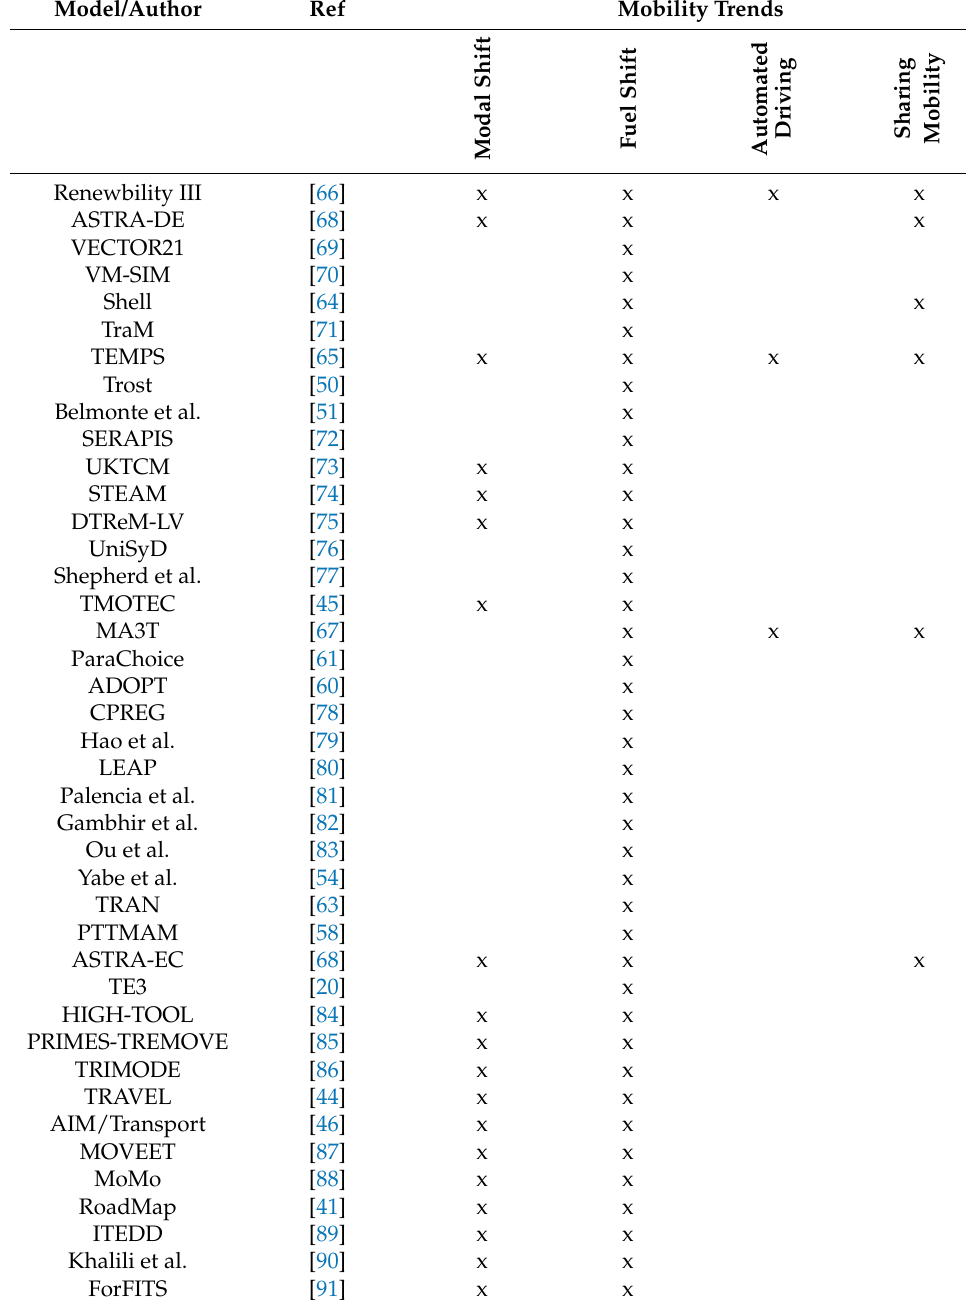
Table A3. Considered mobility trends in investigated